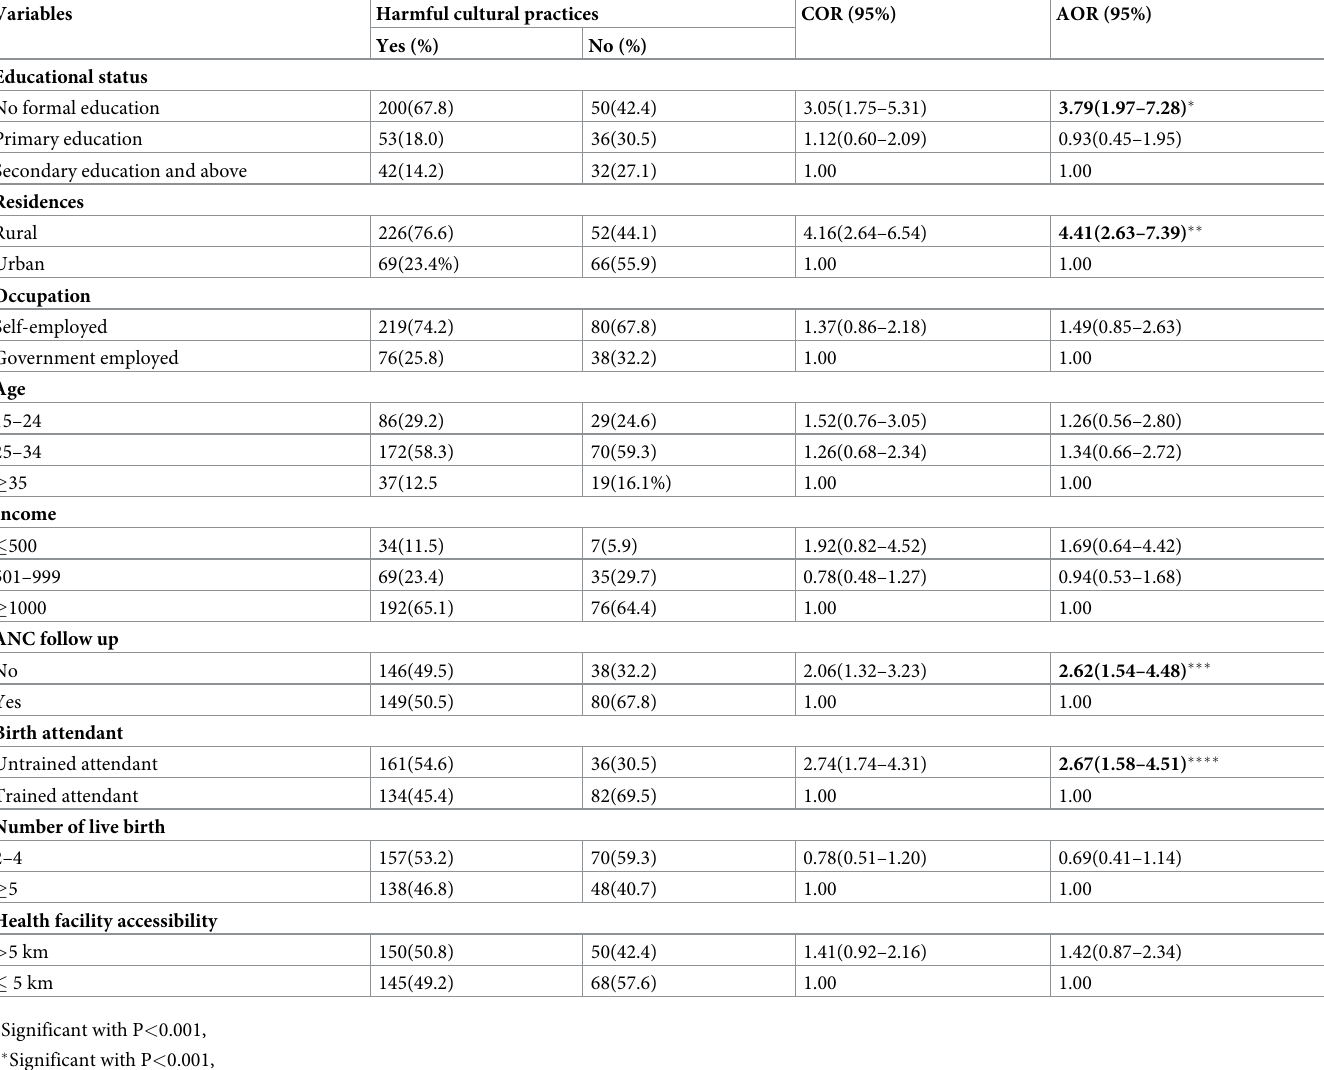
Table 3. Factors associated with harmful cultural practices during the perinatal period in Sothern Ethiopia, 2019 (N = 413).